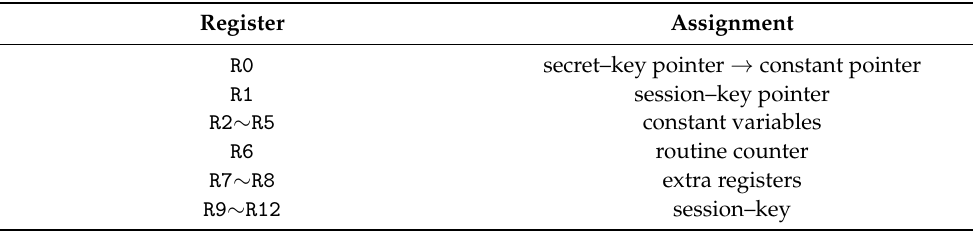
Table 1. Register assignment for key scheduling of HIGHT block cipher on the Cortex-M4